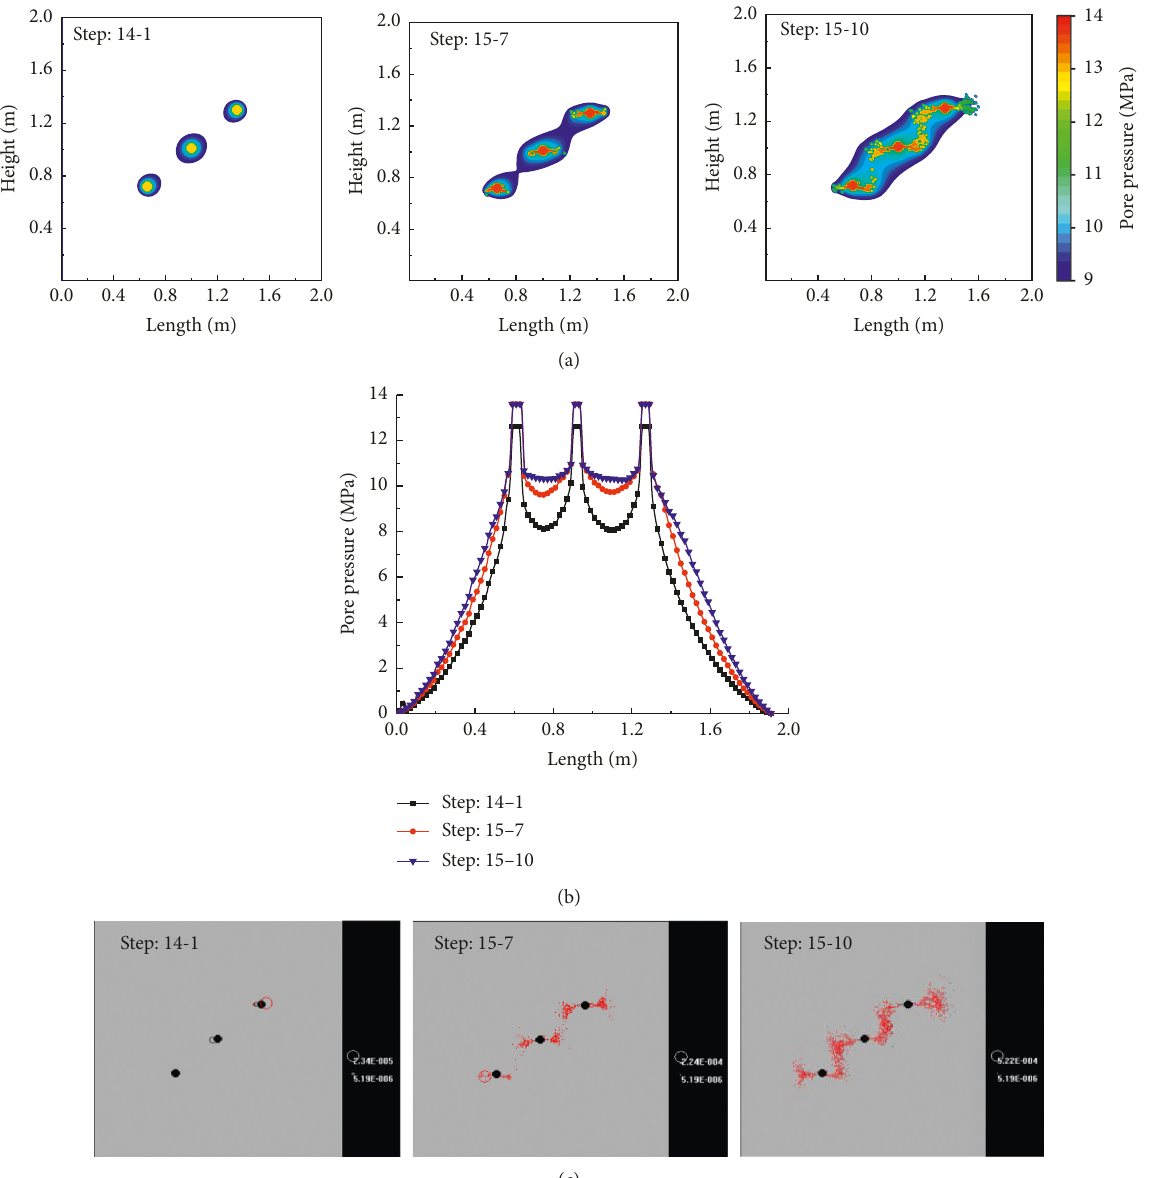
Figure 10: Pore water pressure and evolution of damage due to multicrack propagation. (a) Pore water pressure. (b) Pore water pressure for drilling connections. (c) Acoustic emission